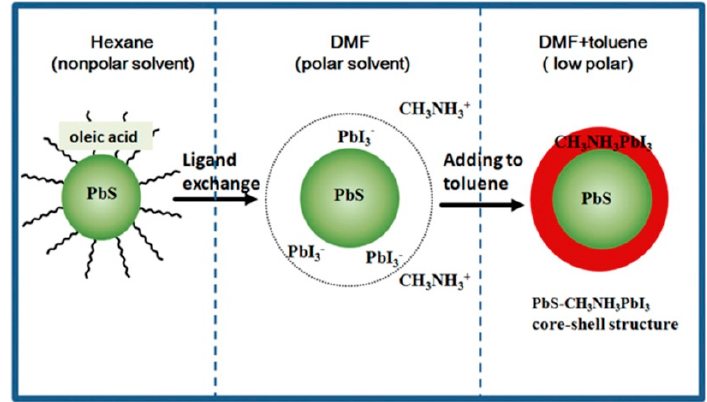
Figure 4. Formation of the PbS-MAPI core-shell nanoparticles by ligand exchange. From [62], reprinted with permission. Copyright © Elsevier 2017.